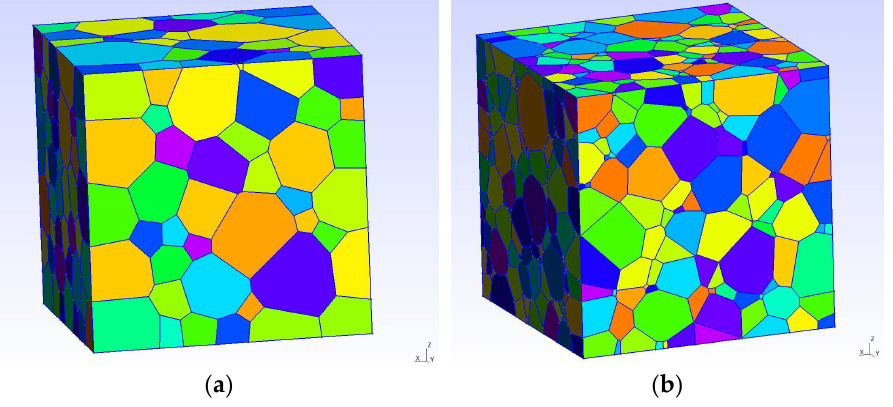
Figure 9. Polyhedral grain structure obtained using Neper at the instants of deformation ε m ( a ) and ε f ( b ).